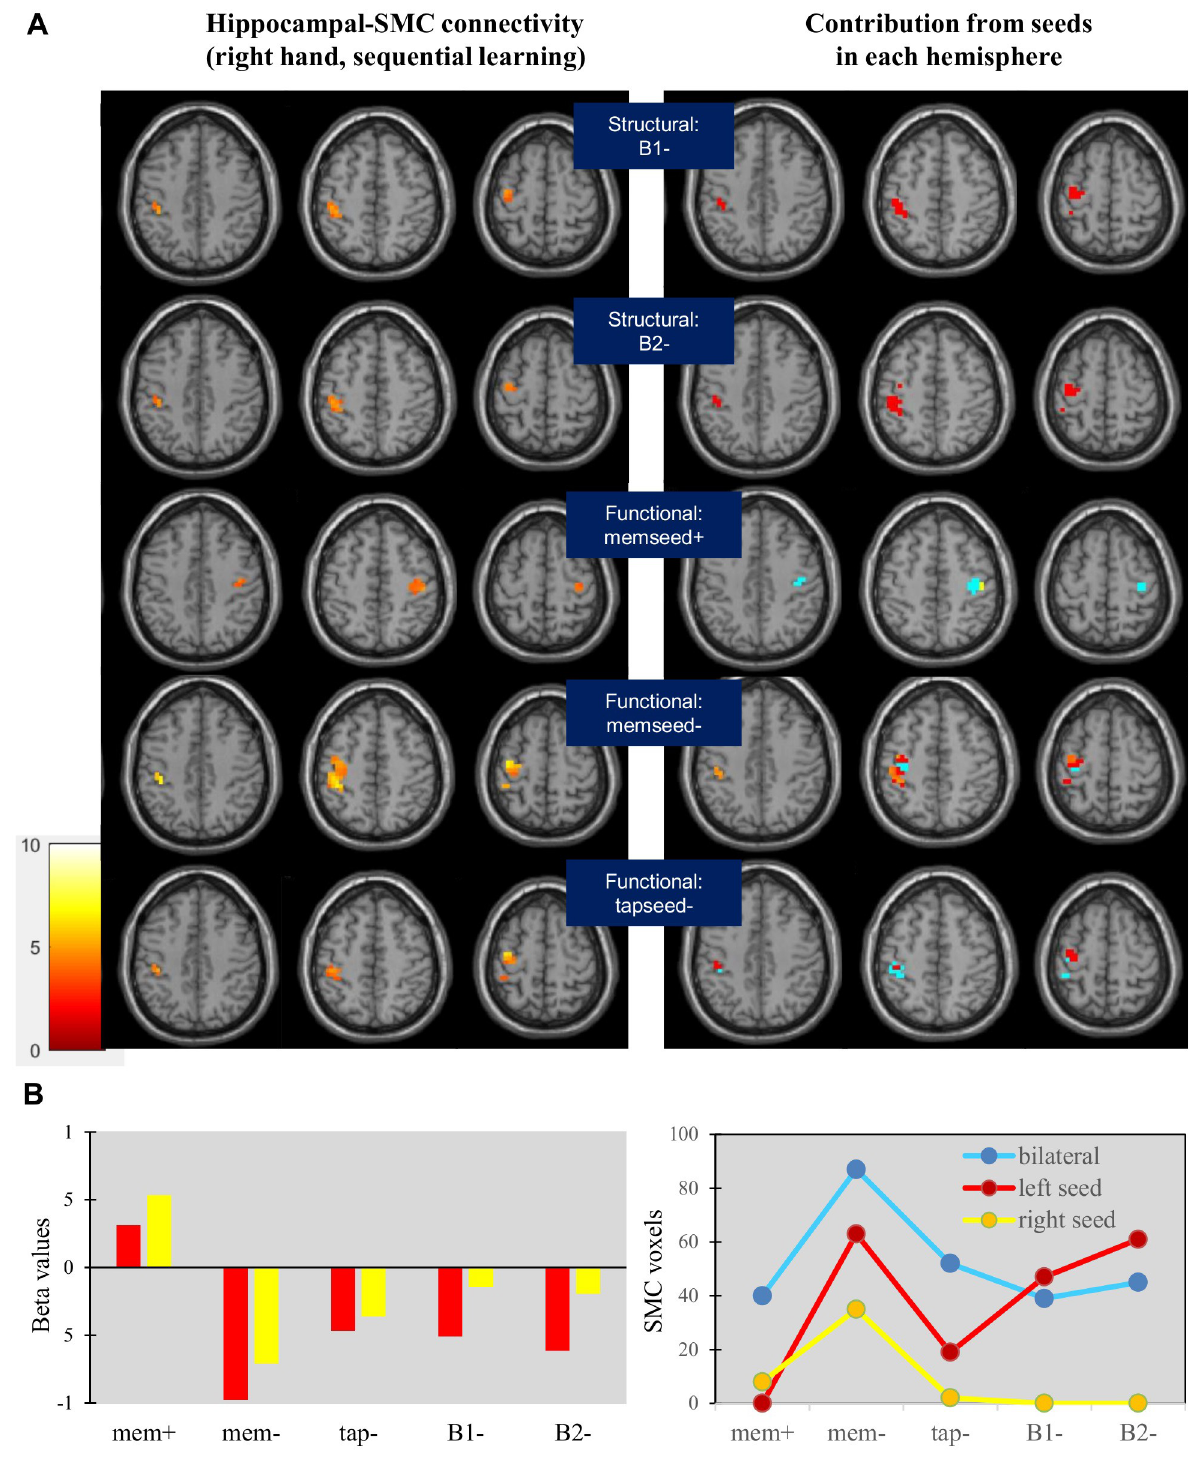
Fig 5. Sensorimotor connectivity of structural and functional seeds during sequential learning. (A) Negative connectivity with the left SMC was generated from three structural seeds (A2, B1, and B2) and a functional seed selected from each motor task; positive connectivity with the right SMC was generated from an anterior functional seed (left column, memseed+). Connectivity from the left hippocampus was more prevalent than from the right (right column). (B) Beta values for connectivity (left) and the total number of SMC voxels with significant connectivity generated from seeds in each hemisphere (right) indicate a role for both the left and right hippocampus. Connectivity from global analysis of both could be greater than connectivity from the left or right hippocampus by itself. https://doi.org/10.1371/journal.pone.0222064.g005 PLOS ONE | https://doi.org/10.1371/journal.pone.0222064 September 19,